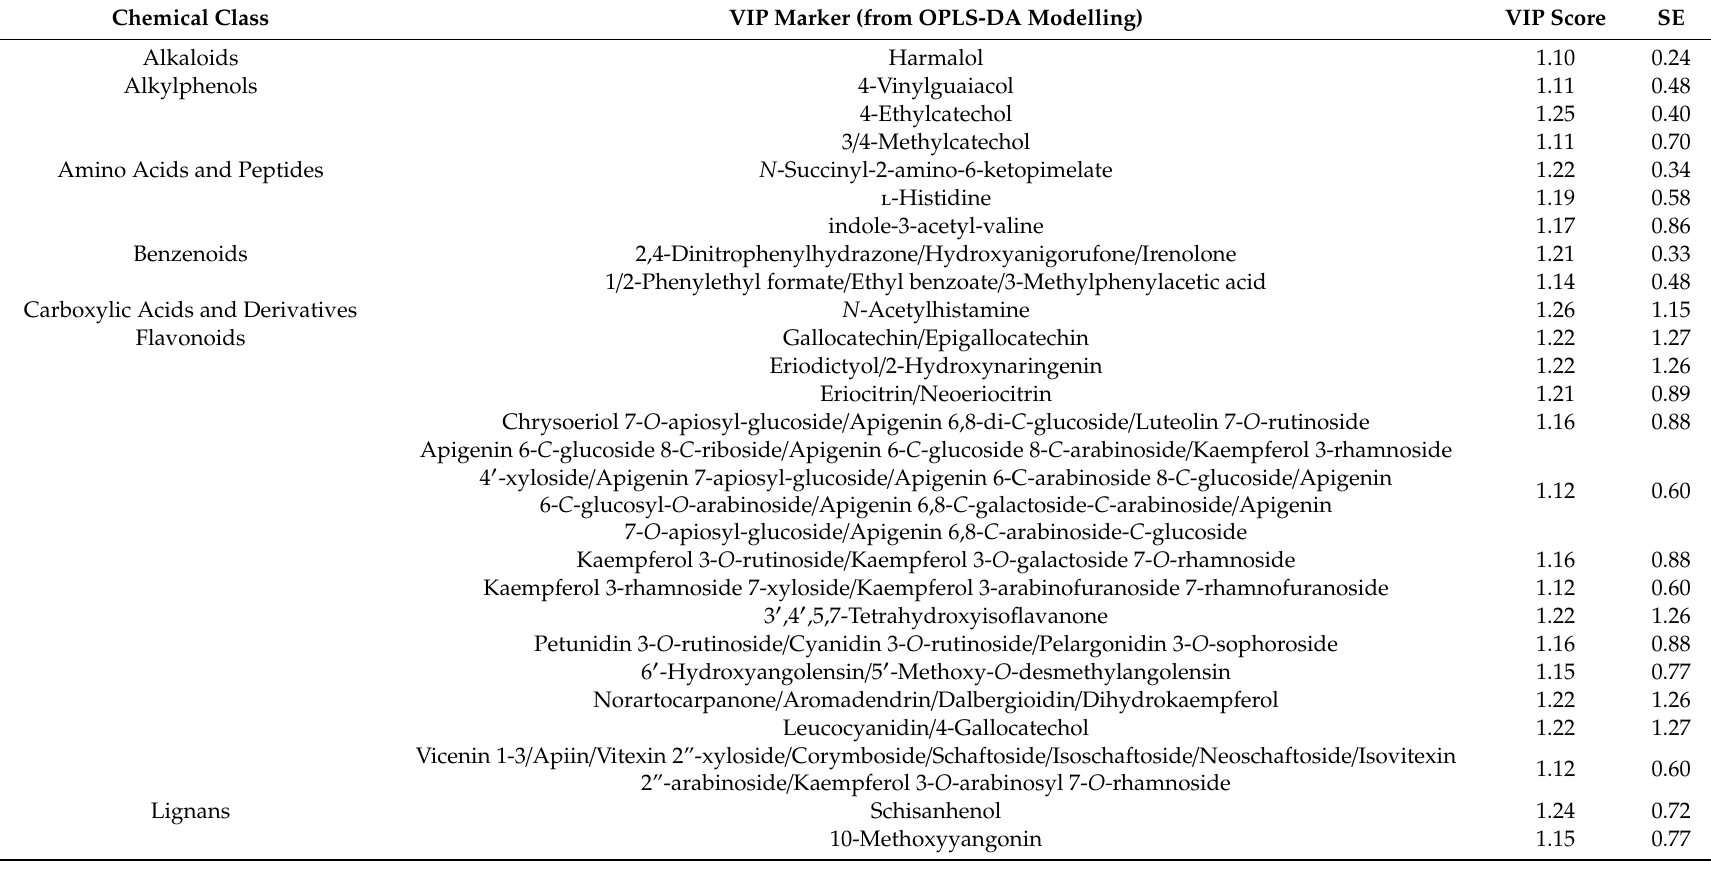
Table 3. VIP marker compounds having the highest discrimination potential when considering the seven artichoke cultivars under investigation. SE = standard